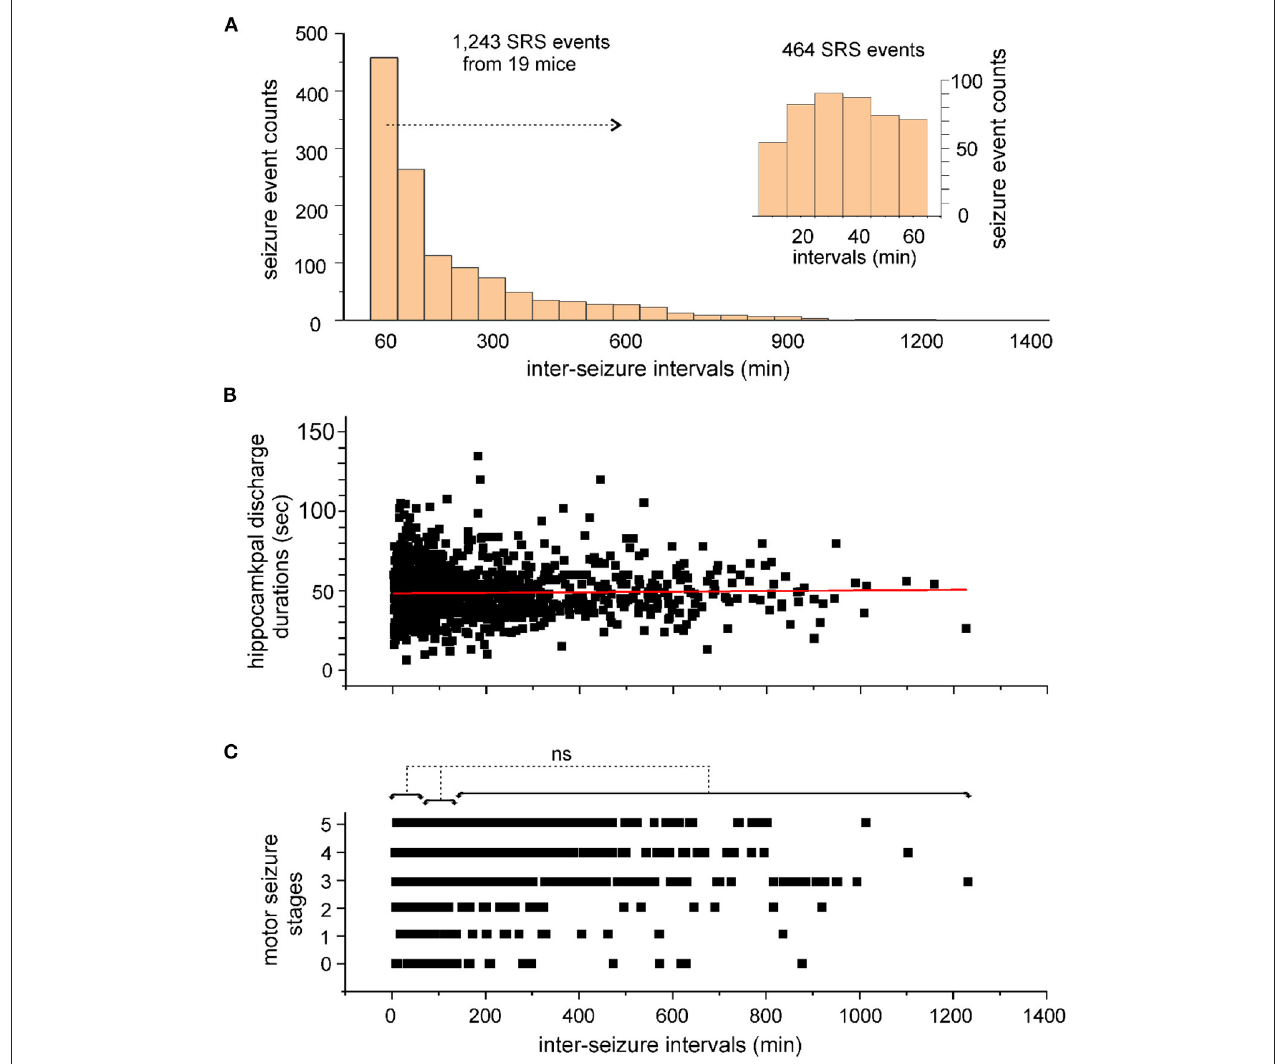
FIGURE 3 | Inter-seizure intervals of SRS events. (A) Inter-seizure intervals (ISIs) of SRS events were estimated in 20 kindled mice. A total of 1,243 ISI estimates were binned every 60min and presented in a histogram. ISIs ≤ 60min were further separated and binned every 10min (A, inset). (B,C) Discharge durations of the kindled hippocampus (B) and corresponding motor seizure scores (C) were plotted against the ISIs. The red line through the data points in B shows the outcome of Pearson’s correlation analysis ( r = 0.025). No significant difference (ns, p > 0.05, nonparametric ANOVA) among motor seizure scores in C was identified among ISIs with lengths ≤ 60min, between 60 and 120min, or between 120 and